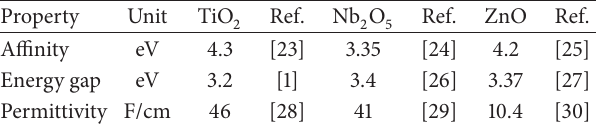
Table 1: Properties of TiO 2 , Nb 2 O 5 , and ZnO.